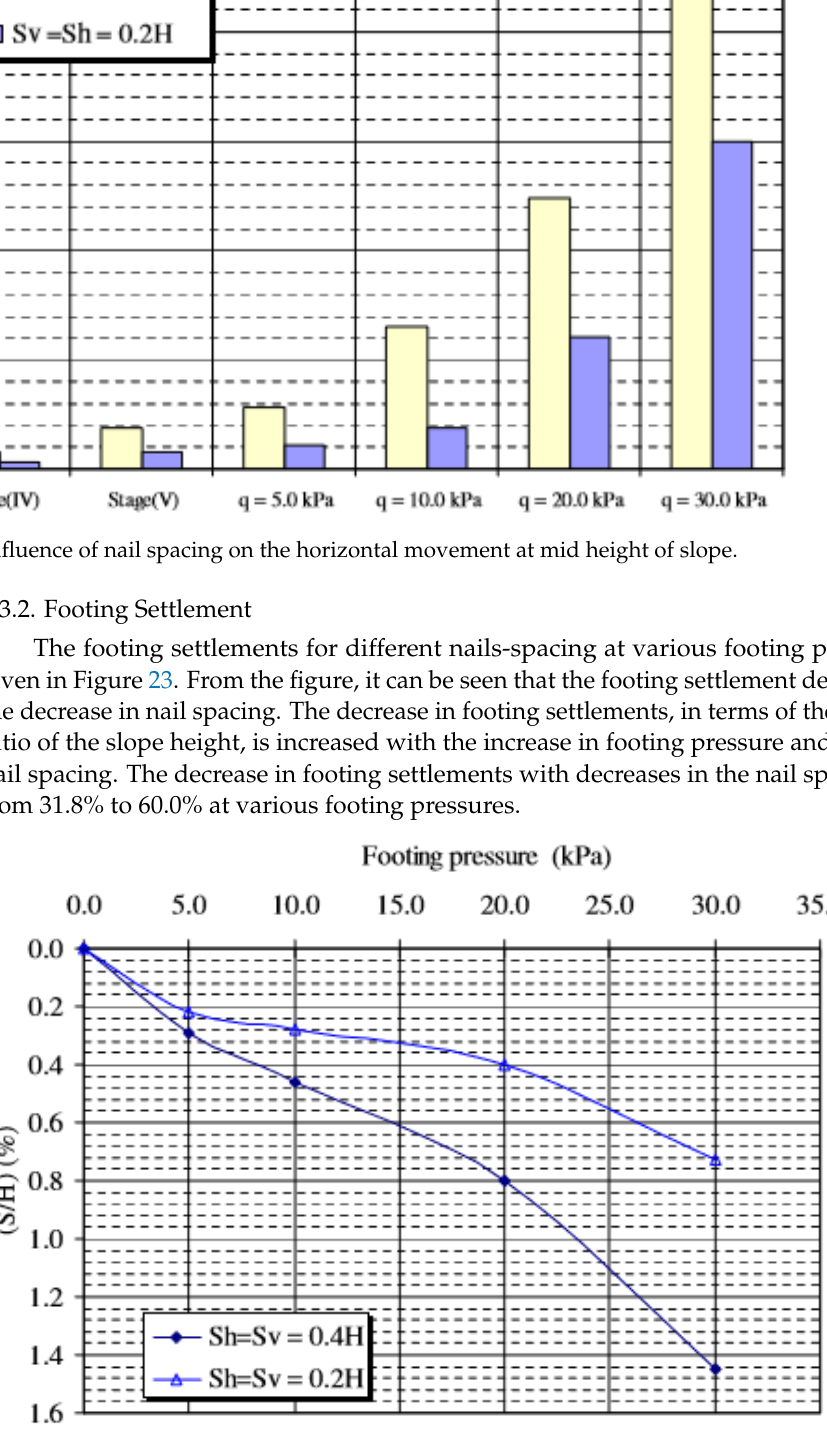
Figure 23. Influence of nail spacing on the settlement of the footing.